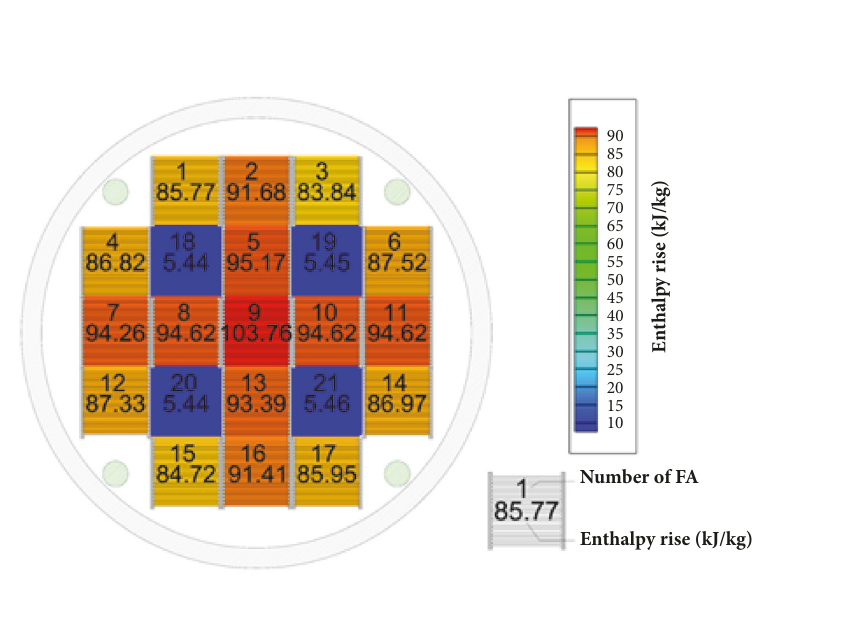
Figure 12: Enthalpy rise for the several fuel assemblies of the CARR reactor obtained with the COTENP